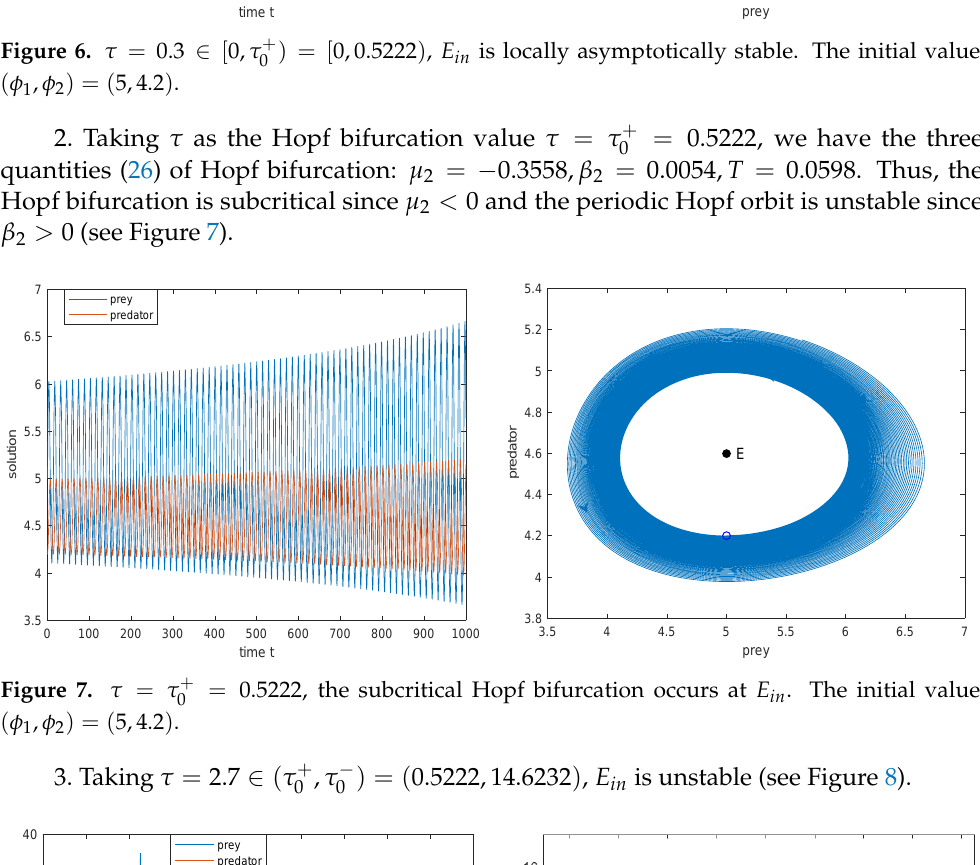
in is locally asymptotically stable. The initial value: